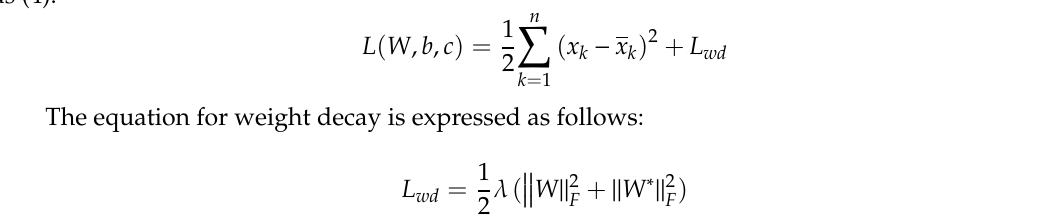
Figure 1. Basic structure of the autoencoder (AE).